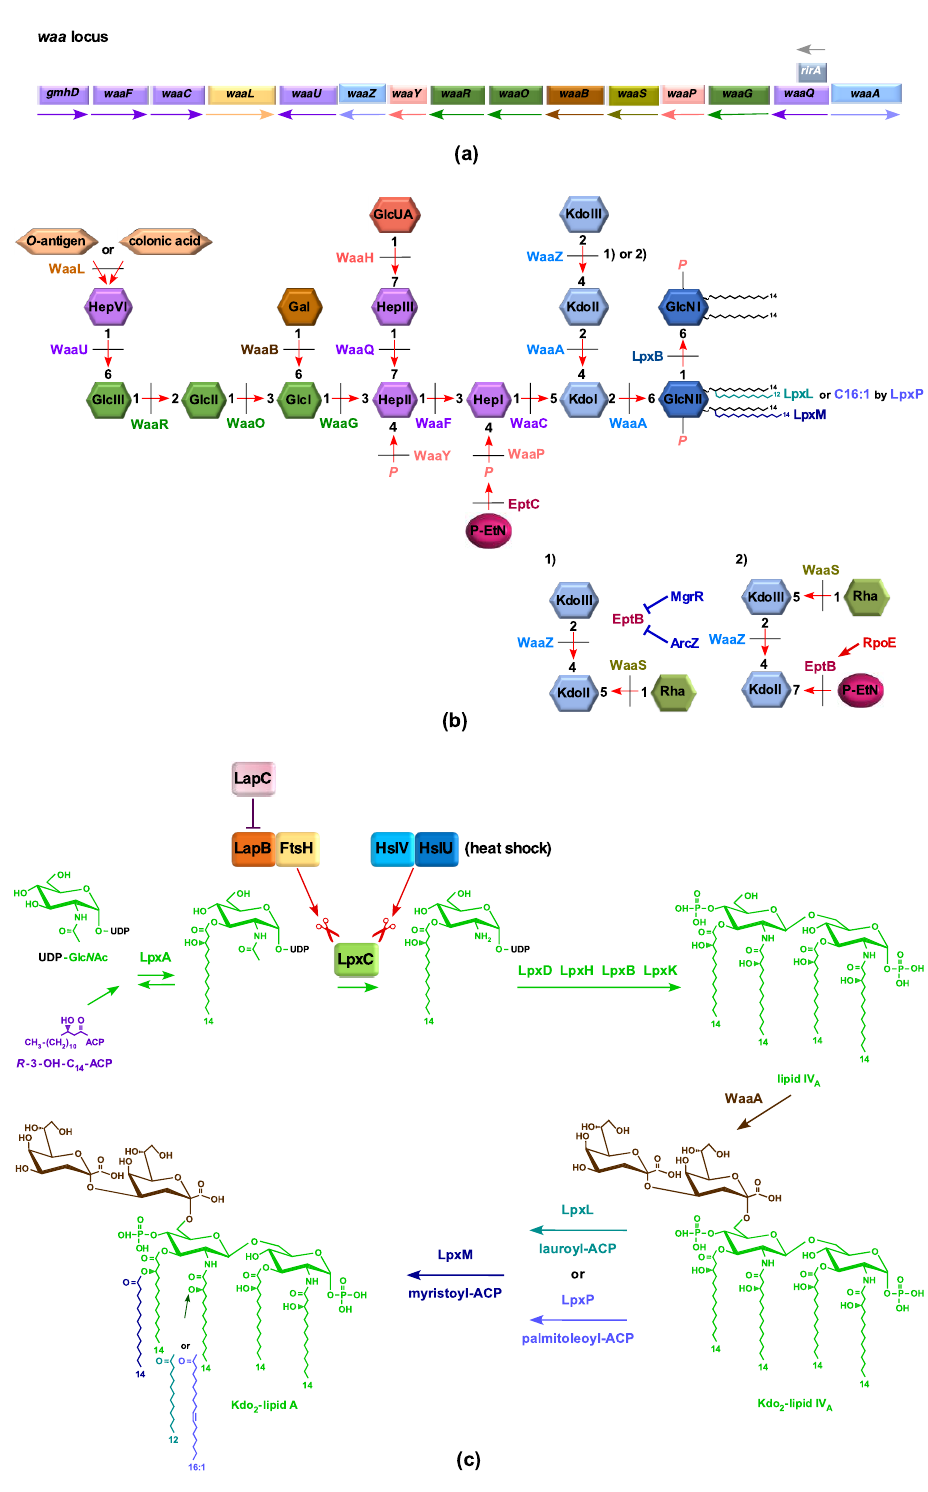
Figure 1. LPS biosynthetic genes and their structural modifications: ( a ) Schematic drawing of the waa locus. Orientations of three operons and genes encoding various biosynthetic enzymes are shown. Also shown is co-transcription of RirA sRNA with waaQ . ( b ) Depiction of the role of various glycosyltransferases and acyltransferases in LPS biosynthesis. The bottom panel 1 highlights inner core alterations that result in the incorporation of a third Kdo and Rha. In panel 2, a shift of Rha attachment to the third Kdo upon the EptB-dependent incorporation of phosphoethanolamine on the second Kdo, when RpoE is induced, is shown. ( c ) Schematic drawing of the Raetz pathway of biosynthesis of Kdo 2 -LA hexa . Critical steps that regulate LpxC levels are